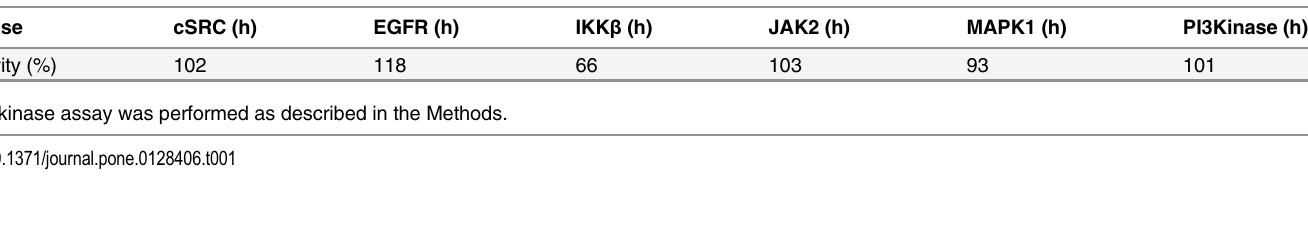
Table 1. Effects of EB (50 μ M) on in vitro kinase